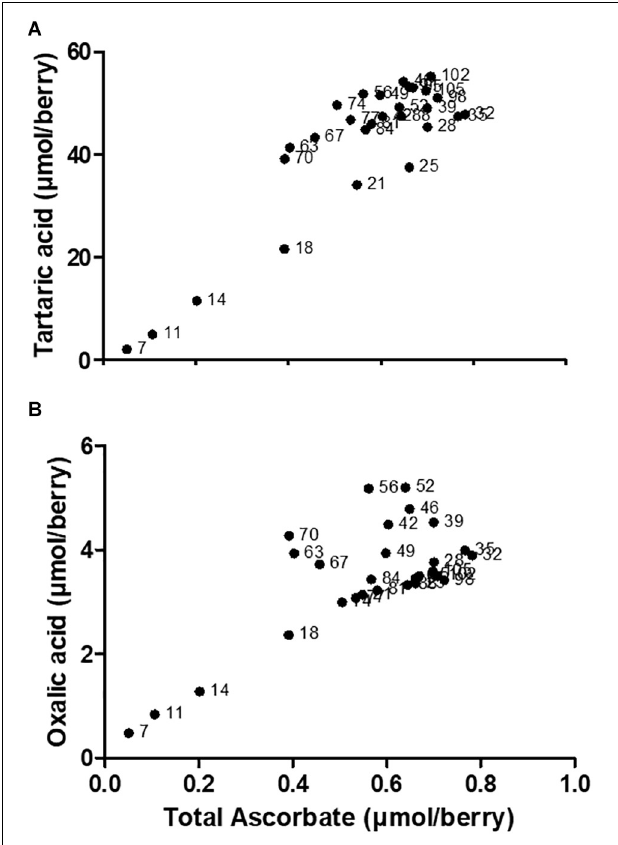
FIGURE 2 | Correlation between (A) tartaric acid and (B) oxalic acid, with total ascorbate across V. vinifera c.v. Shiraz berry developmental series. Data points are labeled with physiological stage of berry (days after flowering). Correlation analysis was conducted using GraphPad Prism 5.01. The spearman correlation coefficients (rs) are 0.6486 and 0.4466, respectively. Adapted from Melino